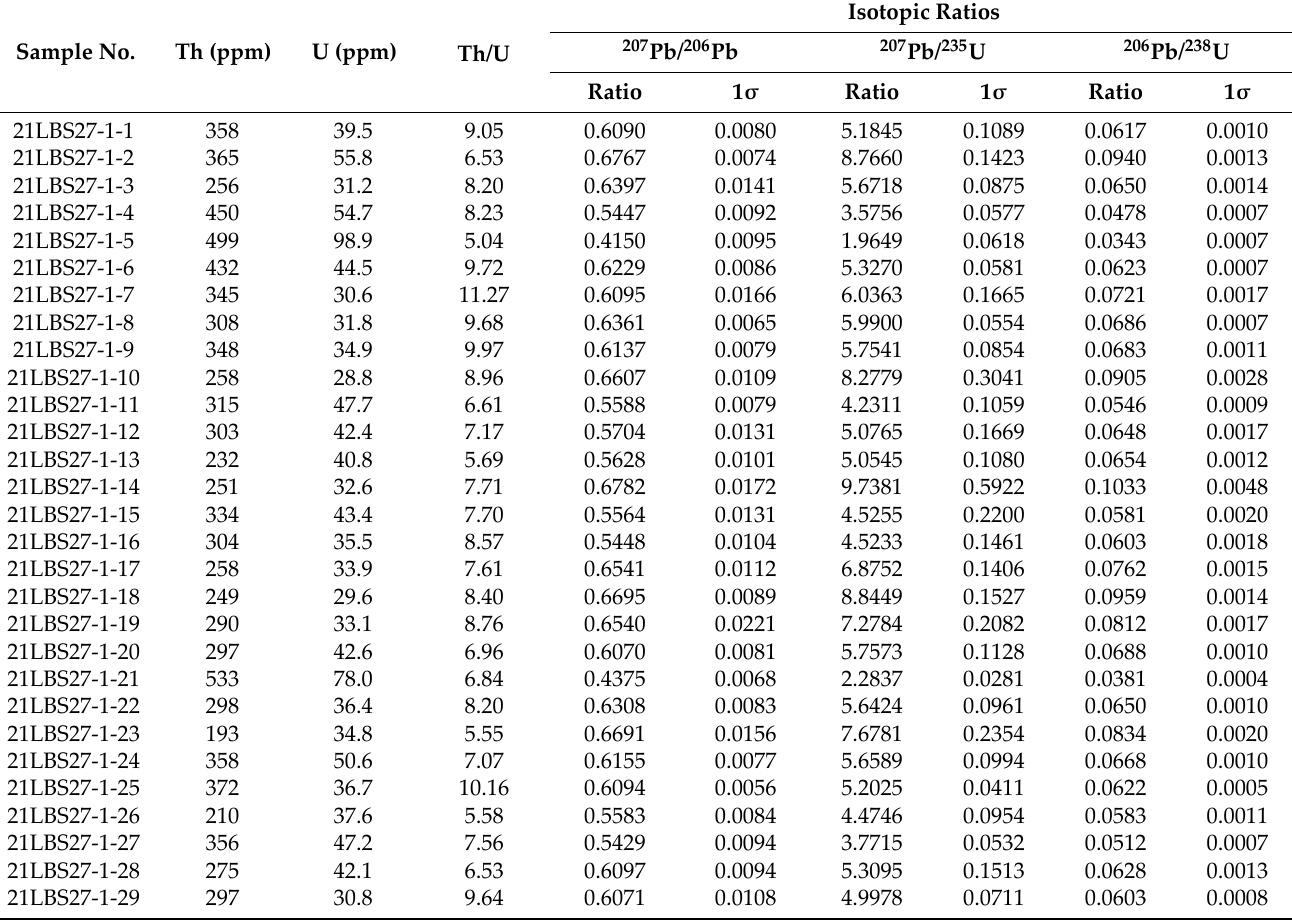
Figure 5. Chondrite-normalized REE patterns of sphene from the hornblende diorite (21LBS27) of the Longbaoshan alkaline complex. Chondrite values are from [59].